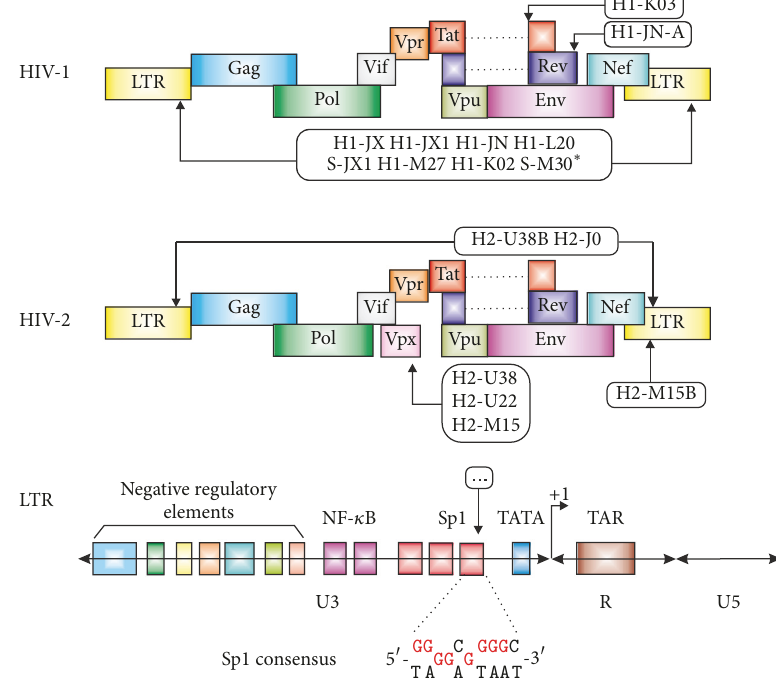
Figure 3: Schematic drawing of the HIV-1 and HIV-2 genome organizations and locations of studied sequence.